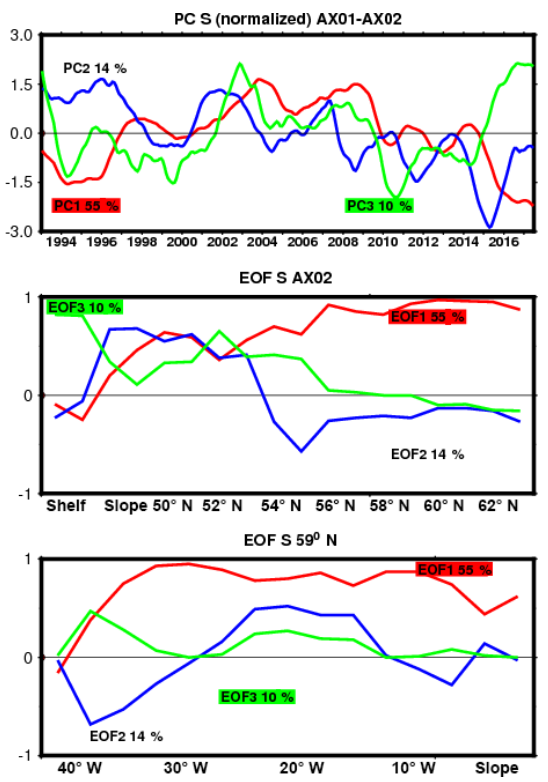
Figure 5. The principal components (PCs) and spatial structure (EOFs) of an EOF analysis of salinity jointly for B-AX01 and B- AX02 (July 1993–December 2017) (we applied a 15-month running mean prior to the EOF analysis). The PCs are normalized to 1, and the EOF scaling is such that 1 indicates that the EOF explains 100% of total local